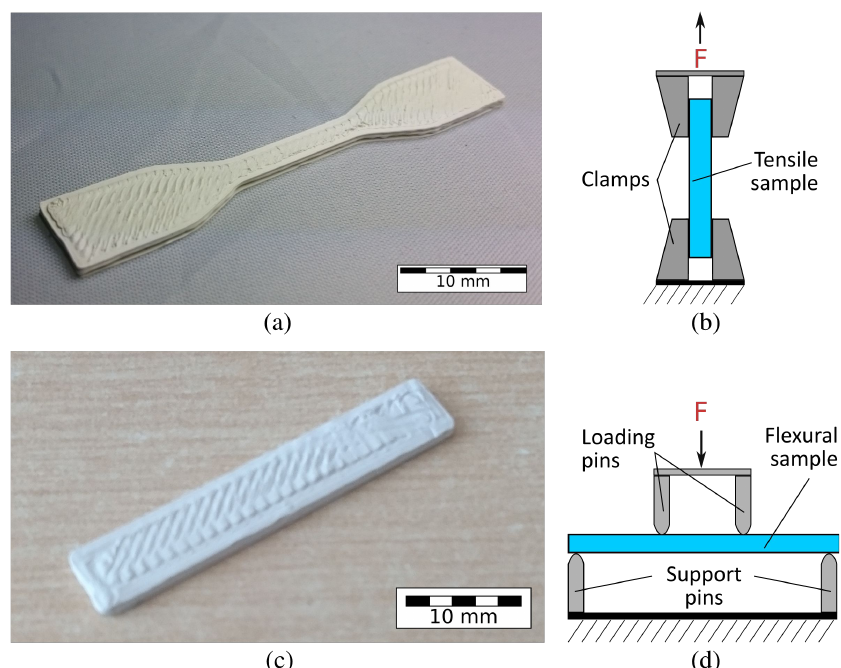
Figure 4. ( a ) A 3D-printed tensile specimen based on the ASTM-D638 (Type IV) standard. ( b ) A schematic of the tensile testing method. The test specimen is clamped on both ends and pulled at a constant velocity, while the force and displacement are measured simultaneously. ( c ) A 3D-printed flexural test specimen based on the ASTM-D7264M standard. ( d ) A schematic depiction of the flexural testing setup. The loading pins, having been spaced one-third of the support span, press down on the specimen till mechanical failure, while the applied force and deflection are